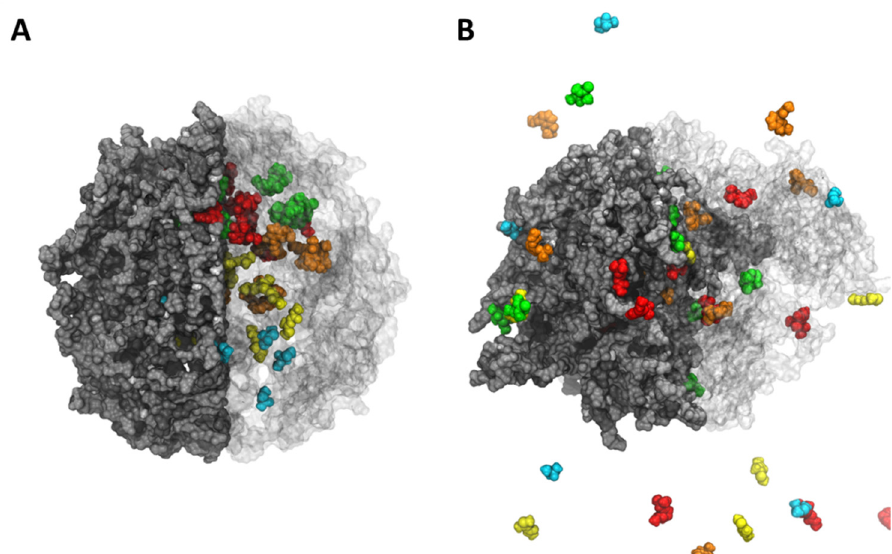
Figure 5. The nanoparticle shape of PVA-MA (with 30% crosslinker ratio) at the ( A ) beginning (0 ns) and ( B ) final simulation time (100 ns). The compounds are shown in different colors. The PVA- MA is represented in gray. The particle was divided for its best representation. The left half shows an opaque representation, while the right half shows the transparent one to be able to visualize the compounds within the particle.